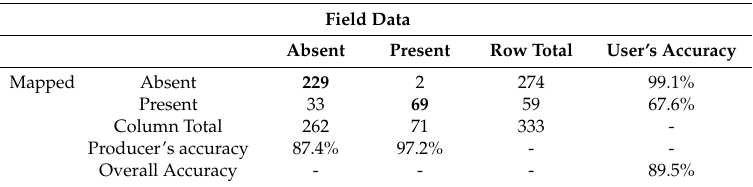
Table 4. Model accuracy of integrated Regression Tree (RT) classification trained with thaw-depth sample points along transects (same training as logistic